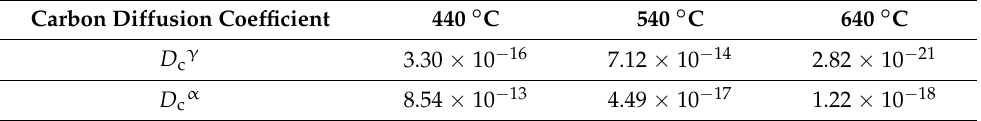
Table 3. Carbon diffusion coefficient in austenite ( D c γ ) and ferrite ( D c α ) and at different